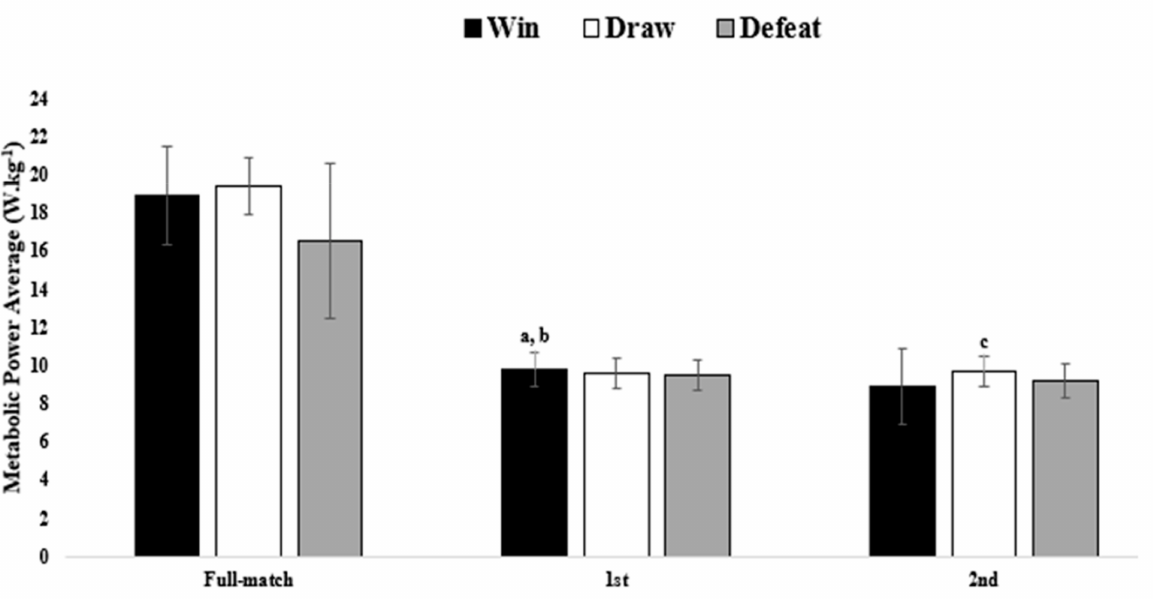
Figure 3. Comparisons based on the match result for metabolic power average between full matches, first and second halves. a denotes difference between win vs draw, b denotes differences between win vs defeat, c denotes differences between draw and defeat, all p values considered at levels